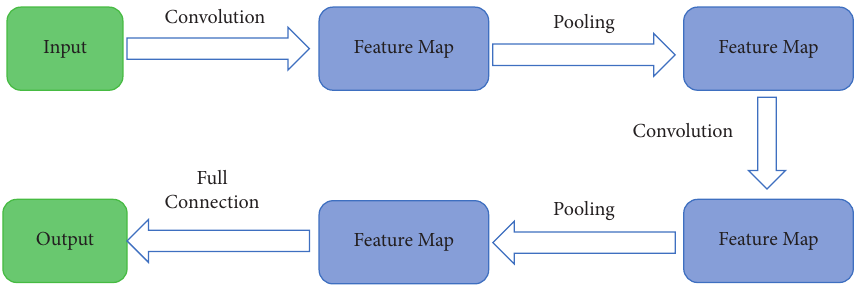
Figure 5: Schematic diagram of CNN